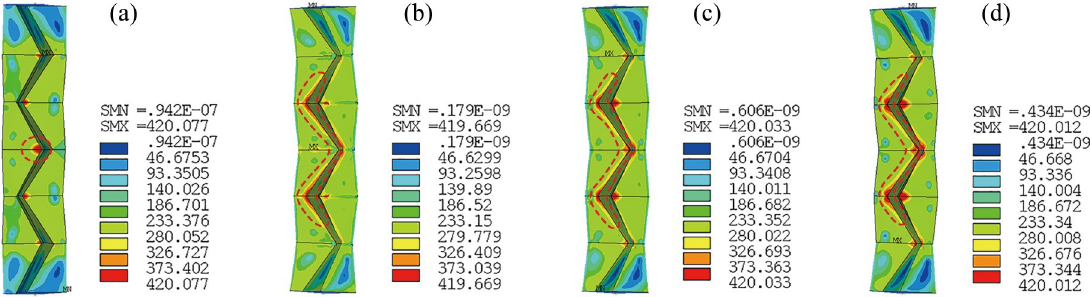
Fig 10. Deformation and stress distribution of tubes at peak points. (a) C-ORI-1; (b) C-ORI-2; (c) C-ORI-3; (d) C-ORI-4.